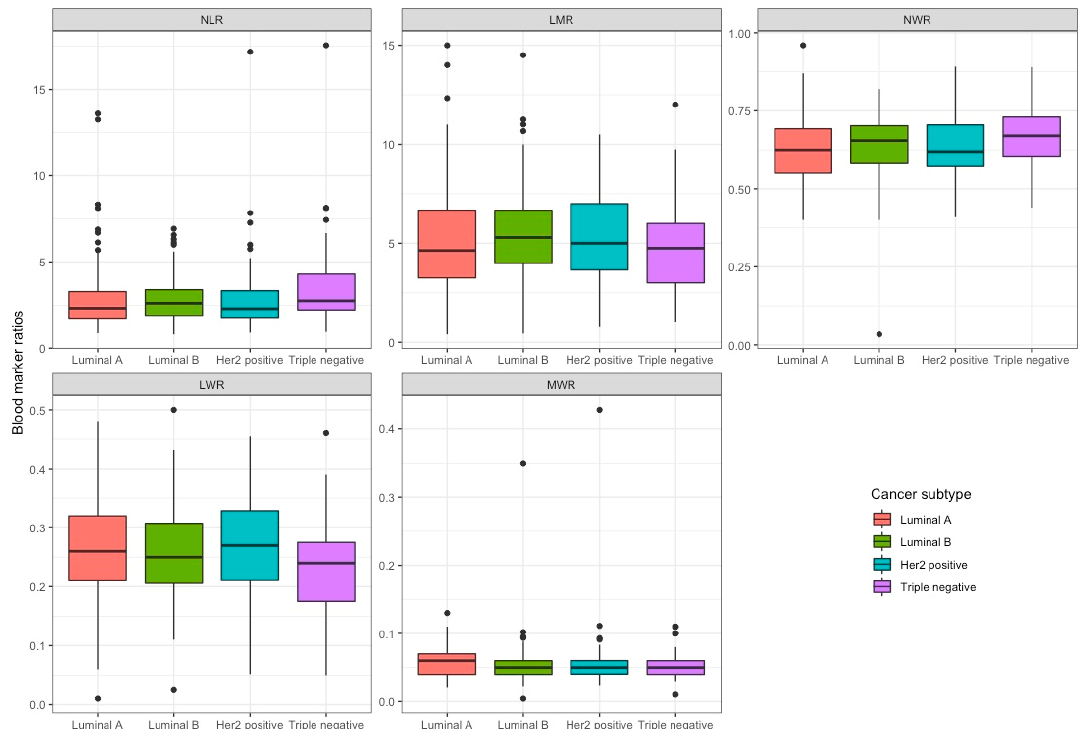
Figure 1. Box plots of immunocyte ratios by indicated breast cancer subtype. Table 3. Median systemic immunocyte ratios.